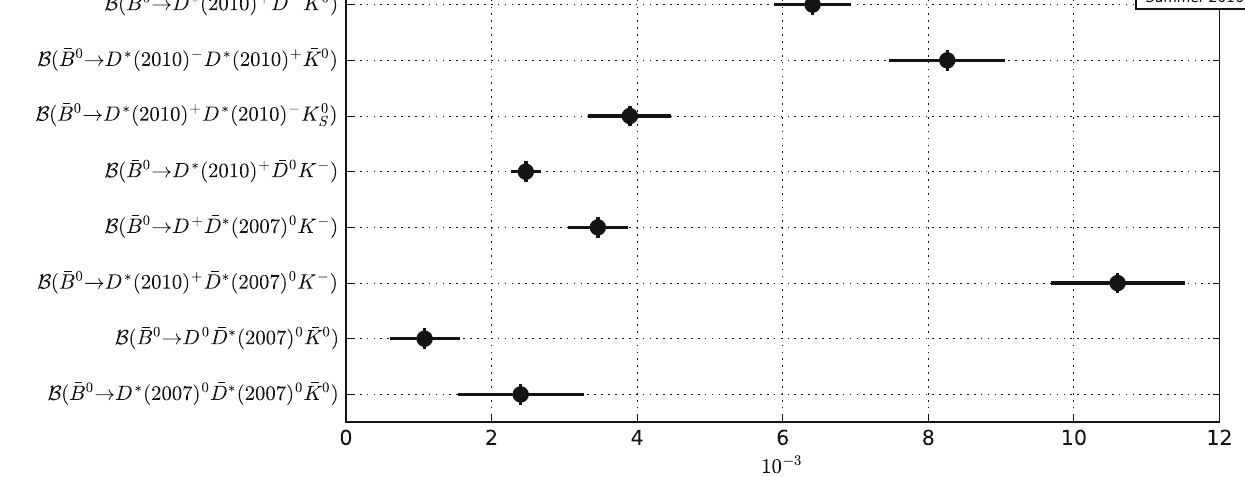
Fig. 82 Summary of the averages from Table 107